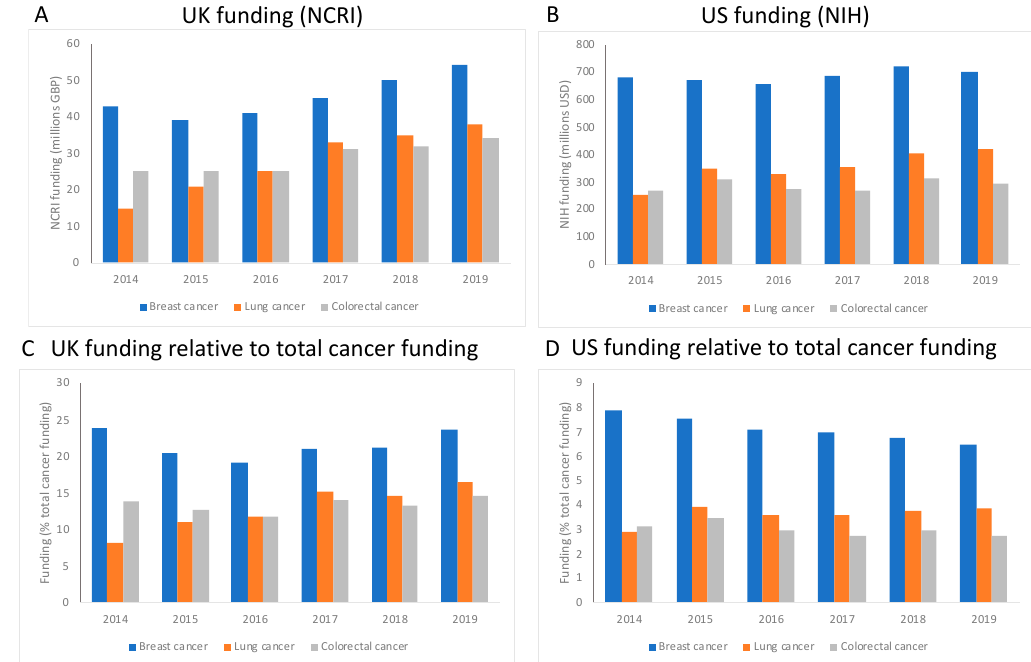
Figure 5. Funding for cancer research in the UK (panels A and C ) and US (panels B and D ) between 2014 and 2019. Data were retrieved from National Cancer Research Institute (NCRI) and NIH databases for the UK and US, respectively. Panels A and B show funding for each selected cancer type for the UK and US, respectively, revealing relatively generous support for breast cancer for both regions. Panels C and D are the funding for the selected cancer types relative to total cancer funding, for the UK and US, respectively. Support has been sustained or increased slightly over time for both regions. Table 3. NIH research project funding, categorized as R01 and year 1 of support, retrieved from NIH RePORT (Table 1) using either breast cancer AND mouse AND xenograft or breast cancer AND organoid between 2014 and 2019. Grants were further scrutinized to ensure that breast cancer was the focus of the research, and that either xenografts or organoids were one of the methodologies described. Total funding for grants that fulfilled these criteria was calculated.